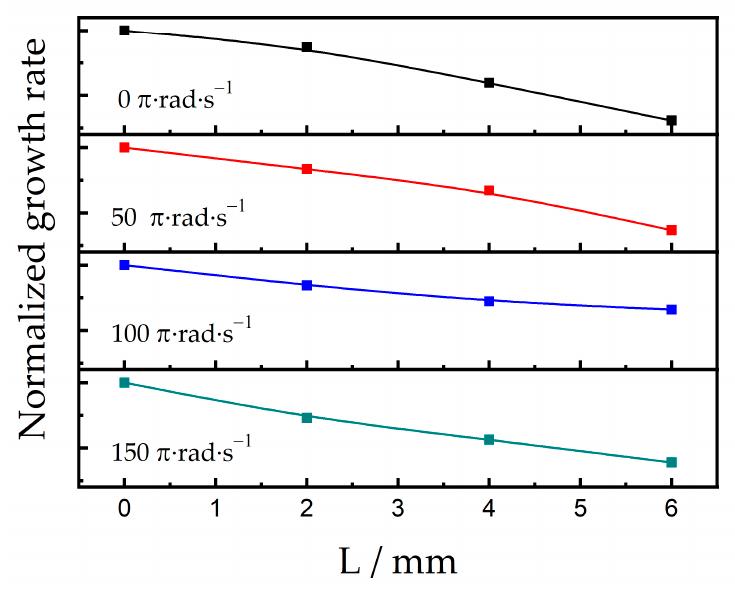
Figure 7. Normalized growth rates of large-area diamond films along the L direction under a dynamic magnetic field with different angular frequencies.